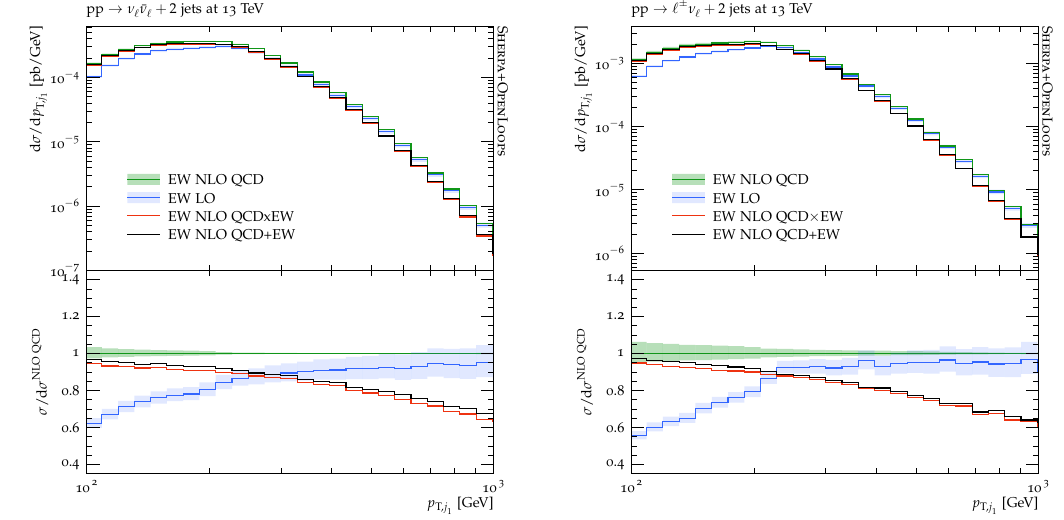
Figure 7. Distribution in the transverse momentum of the hardest jet, p T , j Z ( ν ‘ ¯ ν ‘ ) + 2 jets (left) and EW pp → W ± ( ‘ ± ν ‘ ) + 2 jets (right). Curves and bands as in figure